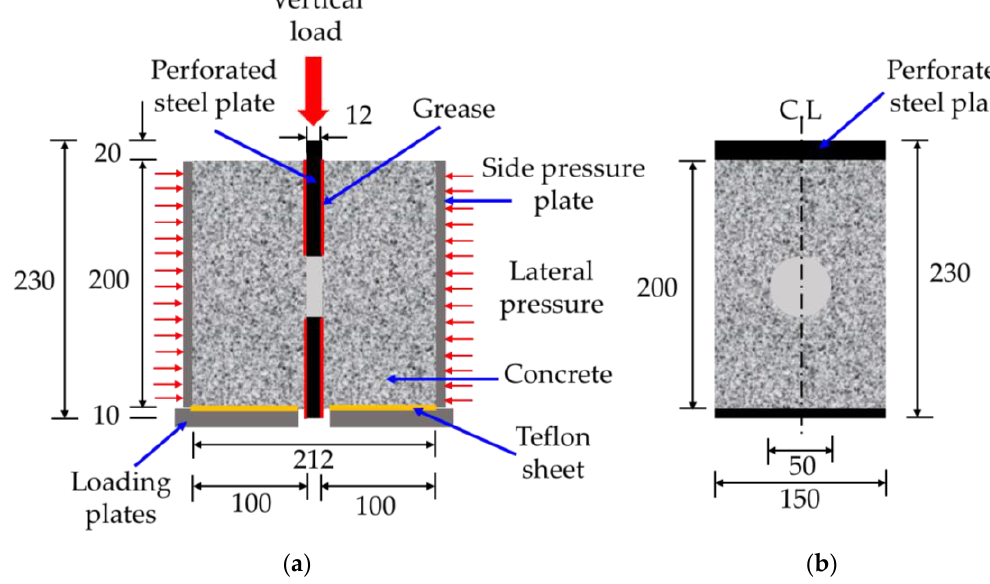
Figure 6. Geometrical details of the test specimen (unit: mm): ( a ) Front view; ( b ) Side view [13].